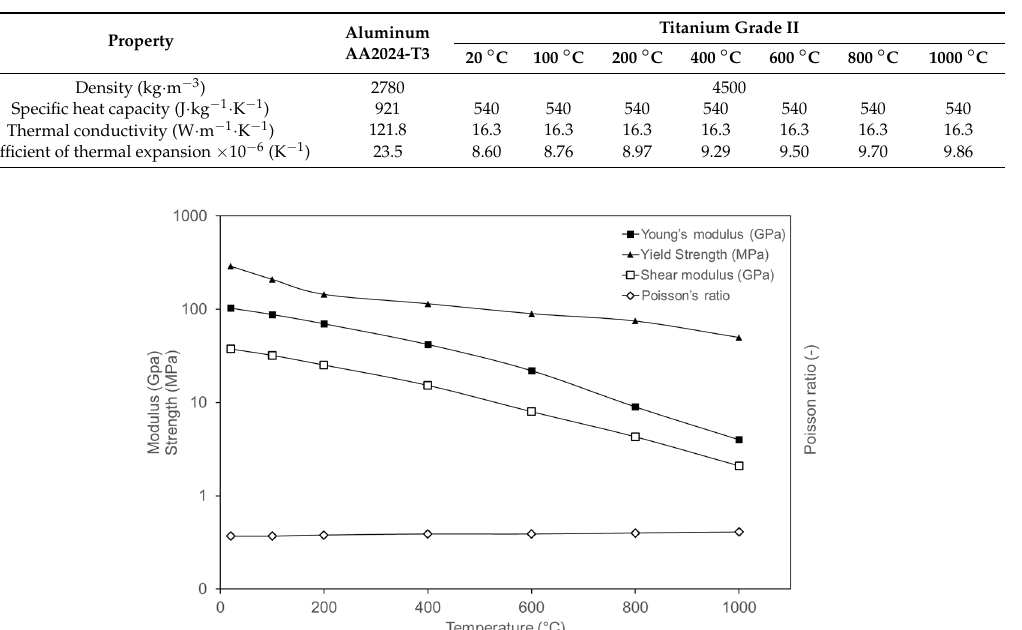
Table 1. Thermo-physical properties of aluminum substrate and titanium coating properties of both materials.